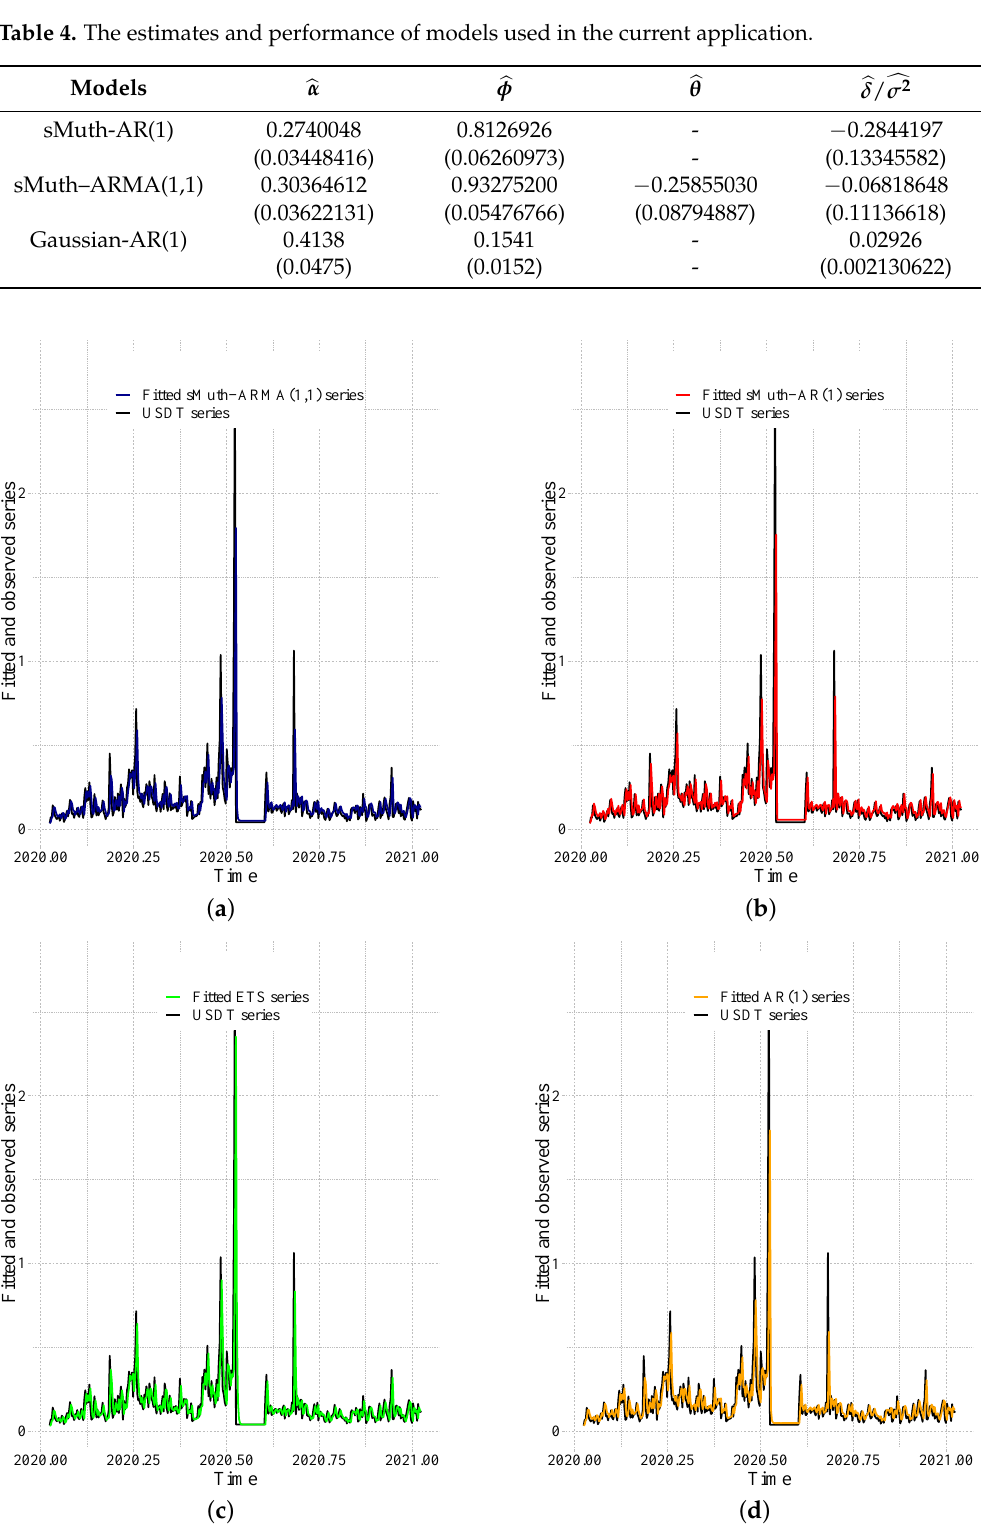
Figure 4. Predicted series and histogram. ( a ) Observed and fitted sMuth–ARMA(1,1) series. ( b ) Ob- served and fitted sMuth–AR(1) series. ( c ) Observed and fitted ETS series. ( d ) The Fitted sMuth and Gaussian